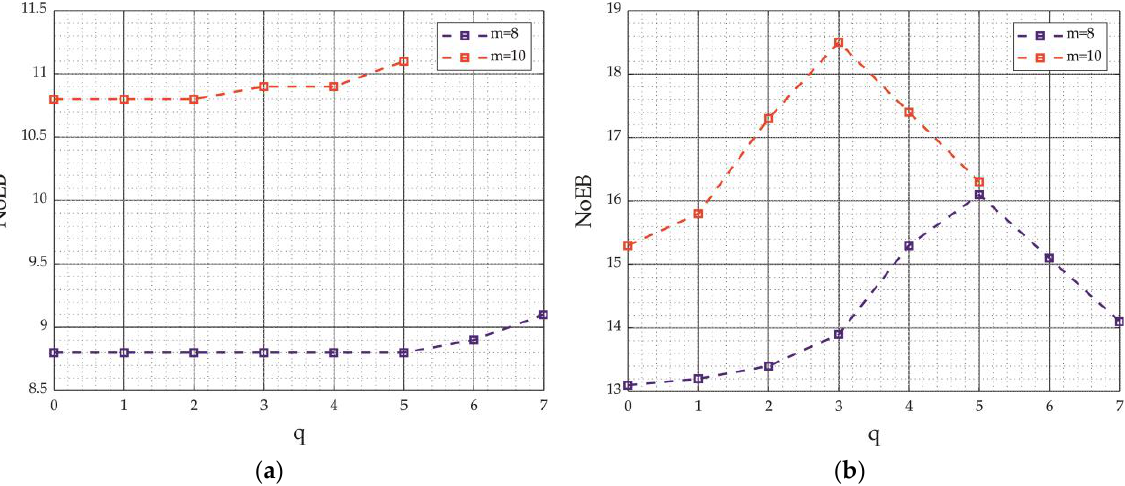
Figure 6. NoEB with respect to q for m = 8 and m = 10 for ( a ) uniform distributed inputs and for ( b ) half- normal distributed inputs (with σ = 2048). The number of bits of the inputs is n =